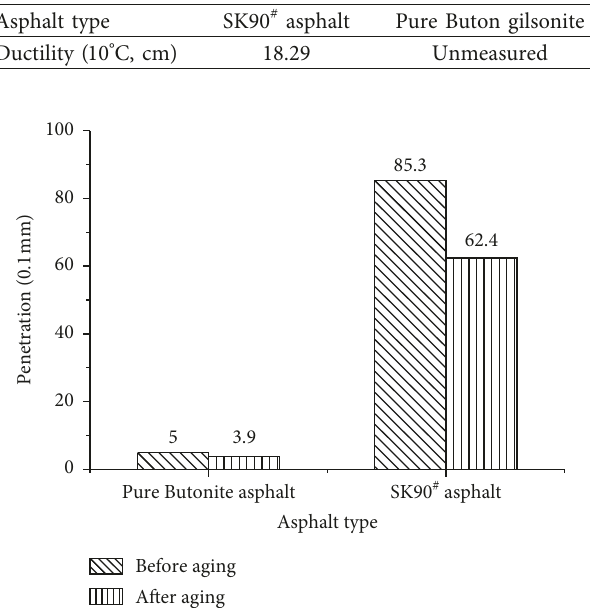
Figure 2: Pure Buton gilsonite and SK90 # DSR Table 3: Comparison of low-temperature performance between pure Buton gilsonite and SK90 # asphalt.